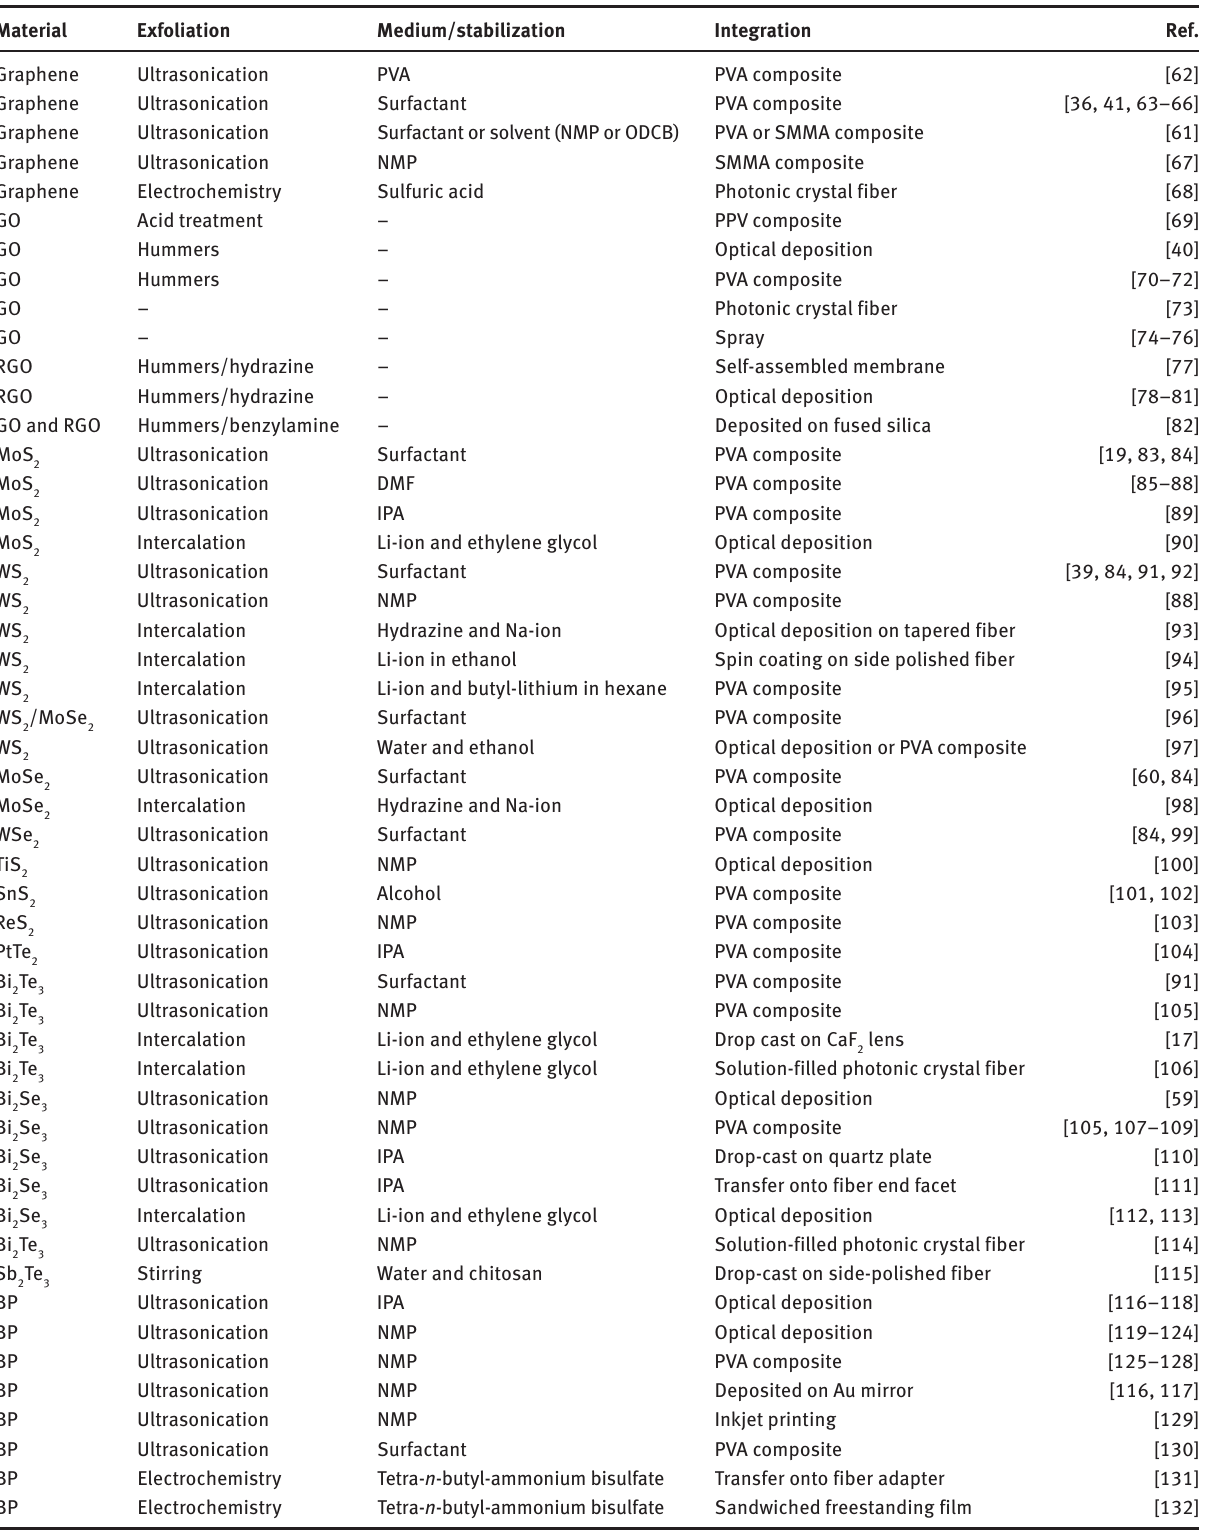
Table 1: Summary of the typical LPE-based 2DM